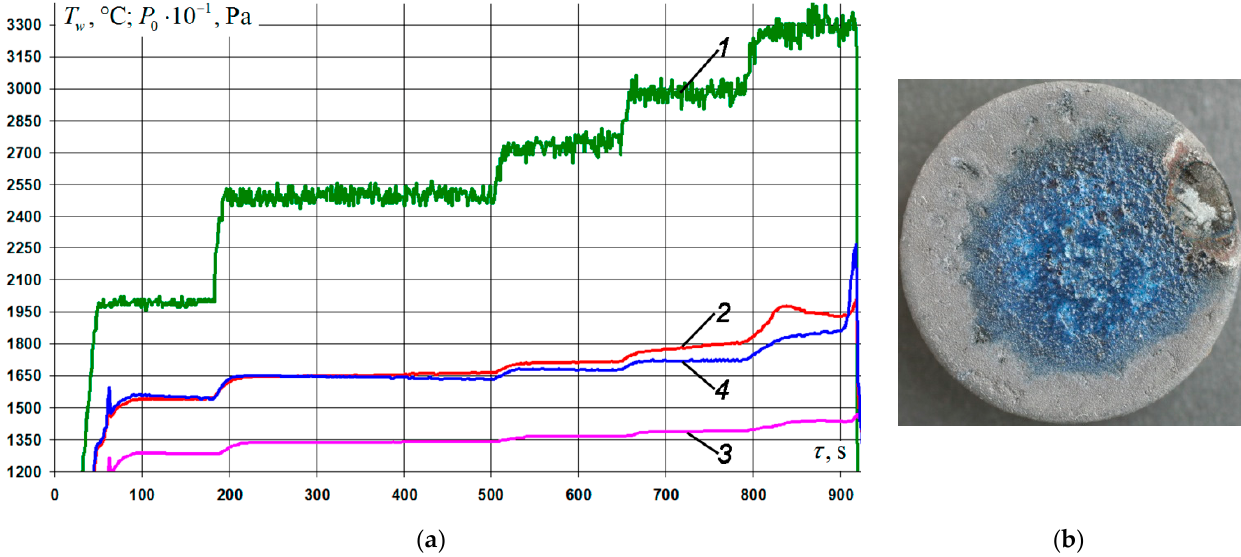
Figure 8. Results of gas-dynamic tests of C f /C–SiC samples coated with the Si–TiSi 2 –MoSi 2 –TiB 2 –CaSi 2 system at P 0 = 20–32.5 kPa: ( a ) change of mode parameters in time: 1—braking pressure in the pre-chamber of the heater, P 0 ; 2, 3—temperature of the front/back surface of the sample at the critical point, T w ; 4—temperature of the front surface of the sample in the “heat” zone, T w ; ( b ) typical view of the front side of the samples after testing.